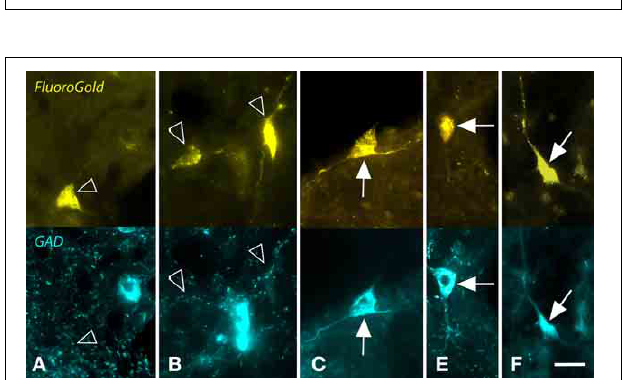
FIGURE 2 | Photomicrographs showing examples of GAD-negative and GAD + cells in the nucleus of the brachium of the inferior colliculus that were retrogradely labeled by a large injection of FluoroGold (FG) into the ipsilateral medial geniculate nucleus. For each panel, the upper image shows cells labeled with FG and the lower image shows the same region visualized for GAD immunoreactivity. (A,B) Examples of FG-labeled cells (open arrows) that were GAD-negative. In both panels, nearby cells were robustly labeled for GAD (blue cells). (C–F) Examples of FG-labeled cells (solid arrows) that were also GAD + . Scale bar = 20 µ m. A,C–E : GP636; B : GP721.